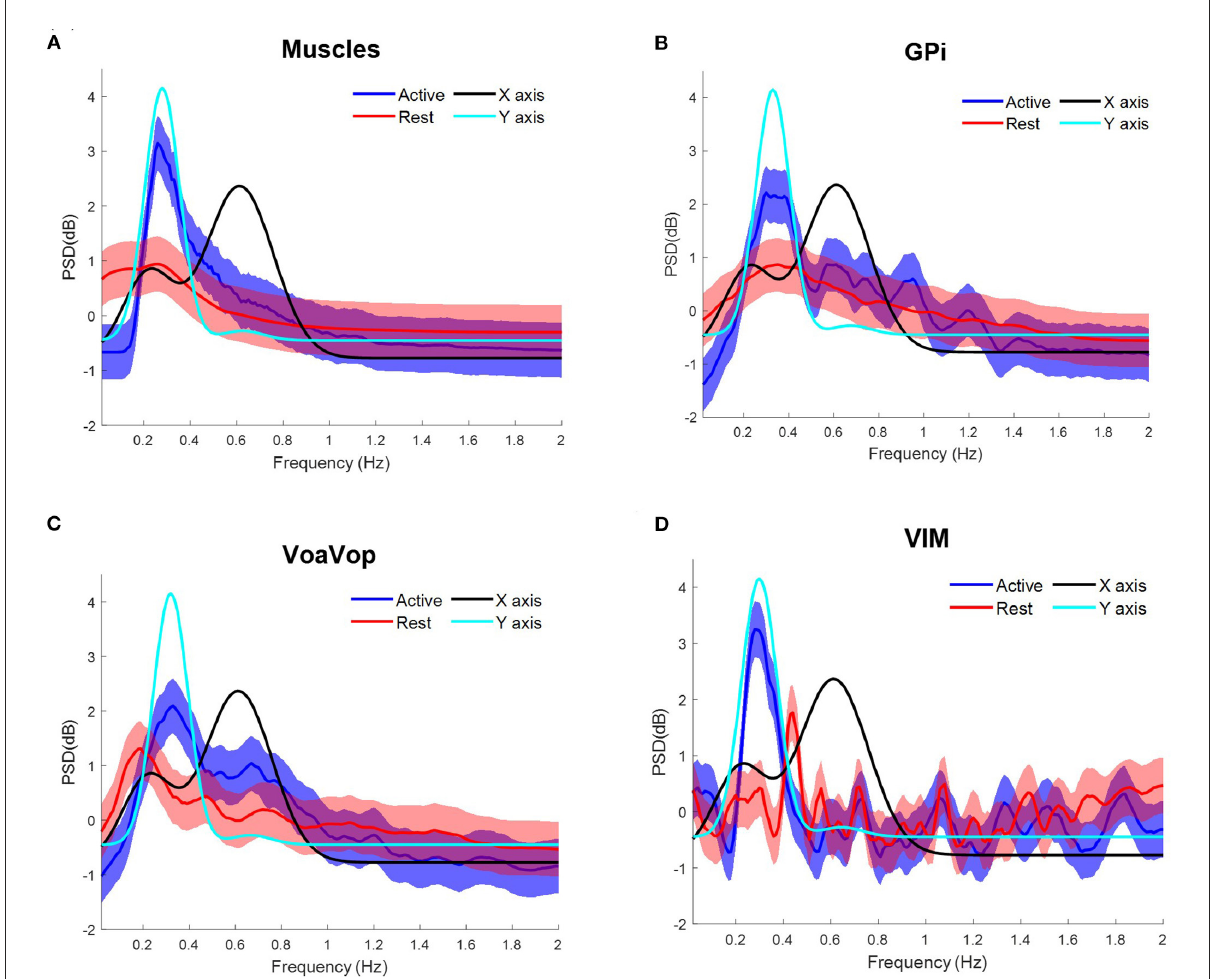
FIGURE3 Task frequency components for the patient with hemidystonia. Contralateral muscles and brain signals during the figure-eight drawing task, recorded from multiple surface EMGs and from multiple externalized DBS electrodes. Power spectrum density (PSD) for kinematic data is shown for comparison: f y component (cyan) and f x component (black). Grand average and standard deviation across all muscles and all microwire electrode recordings during all repetitions of the figure-eight drawing (blue) and resting (red) conditions. (A) Grand average across contralateral muscles. Grand average of left-side brain targets. (B) Brain signals from globus pallidus interna (GPi). (C) ventral oralis anterior/posterior (VoaVop), (D) ventral intermediate (Vim). Vertical axis: power spectra (dB). Horizontal axis: frequency